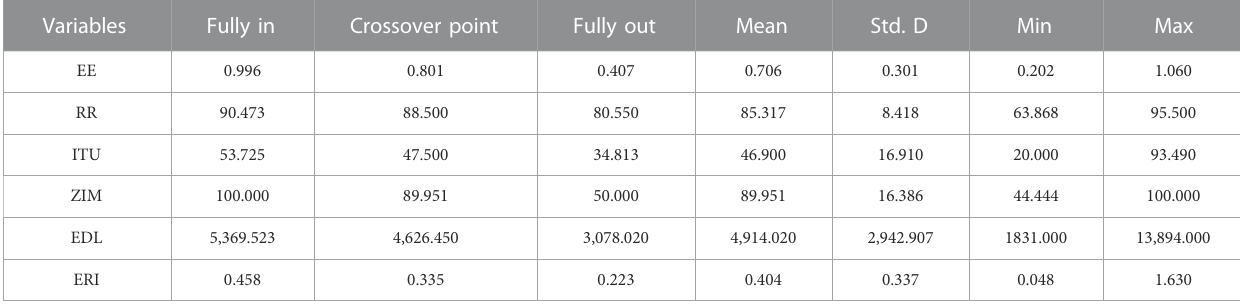
TABLE 2 Variable calibrations and descriptions.